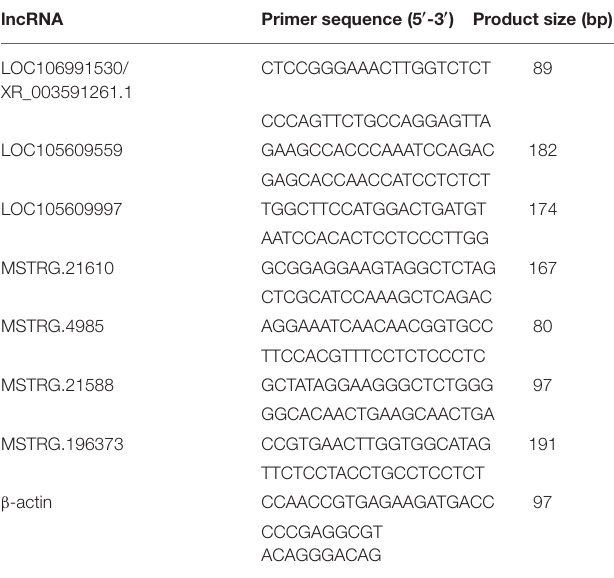
TABLE 2 | Real-time quantitative polymerase chain reaction primers and sizes of the amplification products of the selected lncRNAs and housekeeping genes.